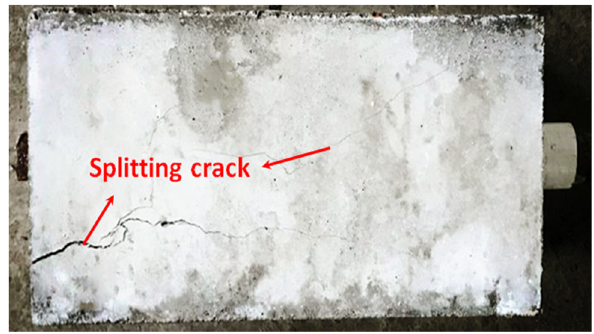
Figure 4: Failure modes after high temperature.